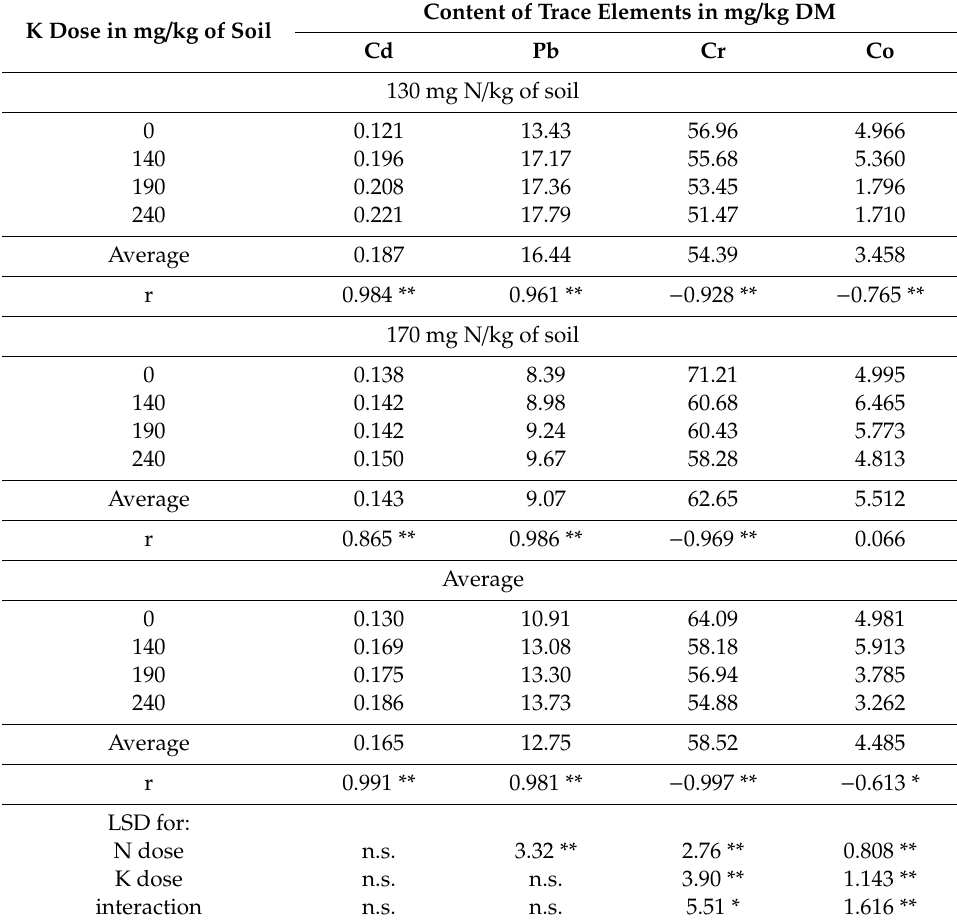
Table 2. Content of cadmium (Cd), lead (Pb), chromium (Cr), and cobalt (Co) in soil (mg / kg DM). K Dose in mg / kg of